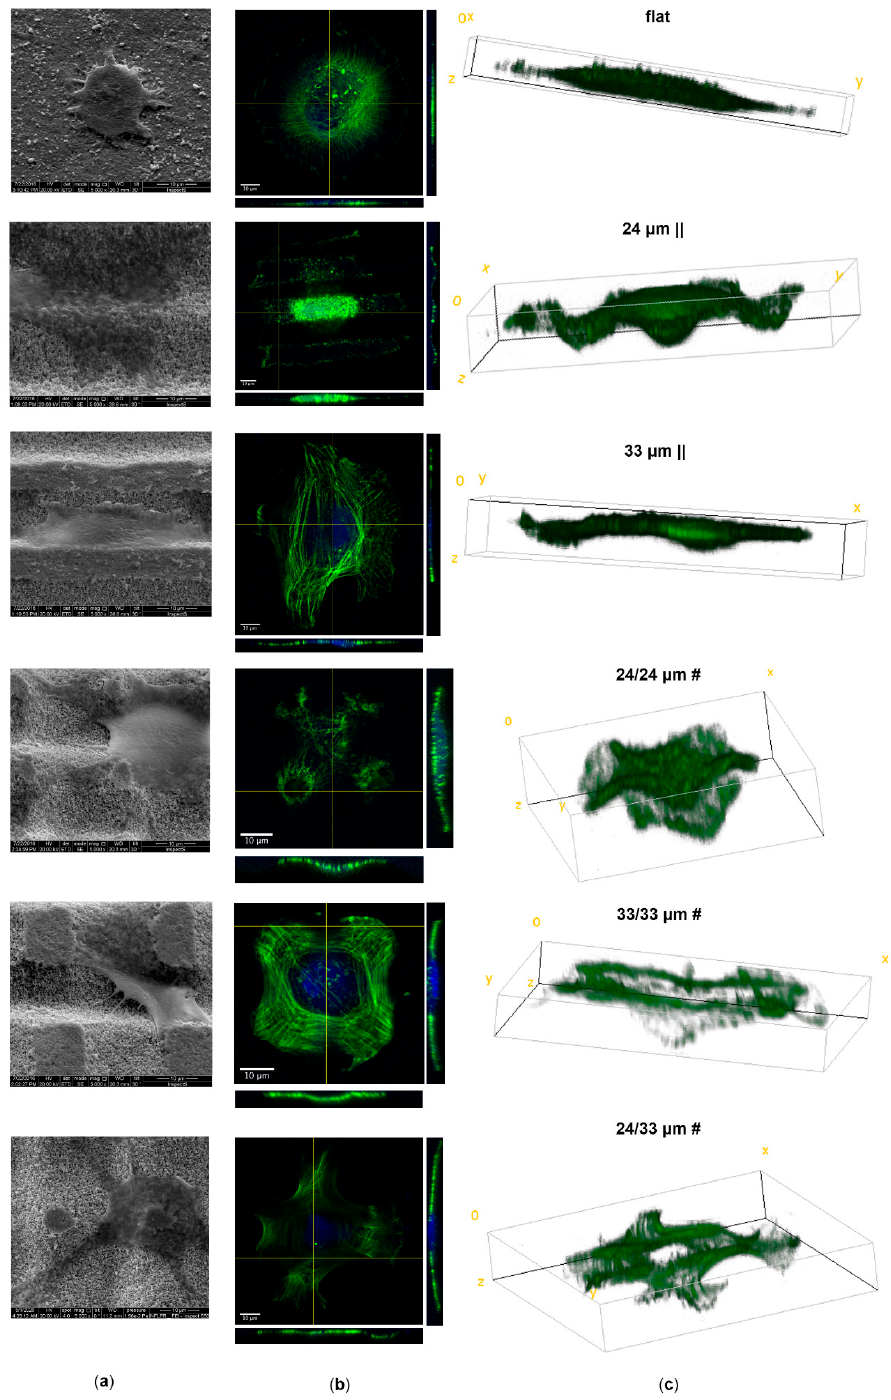
Figure 4. Early attachment of human mesenchymal stromal / stem cells (hMSCs) onto Zirconia microtopographies. Scanning electron microscopy (SEM) ( a ), orthogonal sliced confocal microscopy images ( b ) (scale bars = 10 µ m), and their corresponding 3D rendering ( c ) at 3 h post-seeding onto the tested biomaterials. High-magnification SEM images are presenting individual cell interactions with each of the structured Zirconia substratum. The fluorescence images were obtained upon staining of actin filaments with Alexa Fluor 488-Phalloidin (green) and nuclei with Hoechst (blue). Image acquisition was performed using the Zeiss LSM-710 laser scanning